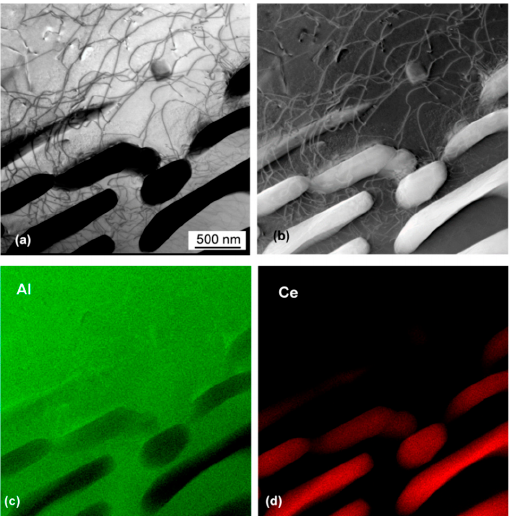
Figure 11. TEM view of the lamellar eutectic in the Al–5Ce alloy: ( a ) bright field image; ( b ) HAADF image; ( c ) EDS map showing distribution of Al; and ( d ) EDS map of Ce. Alloy: Al–5Ce.